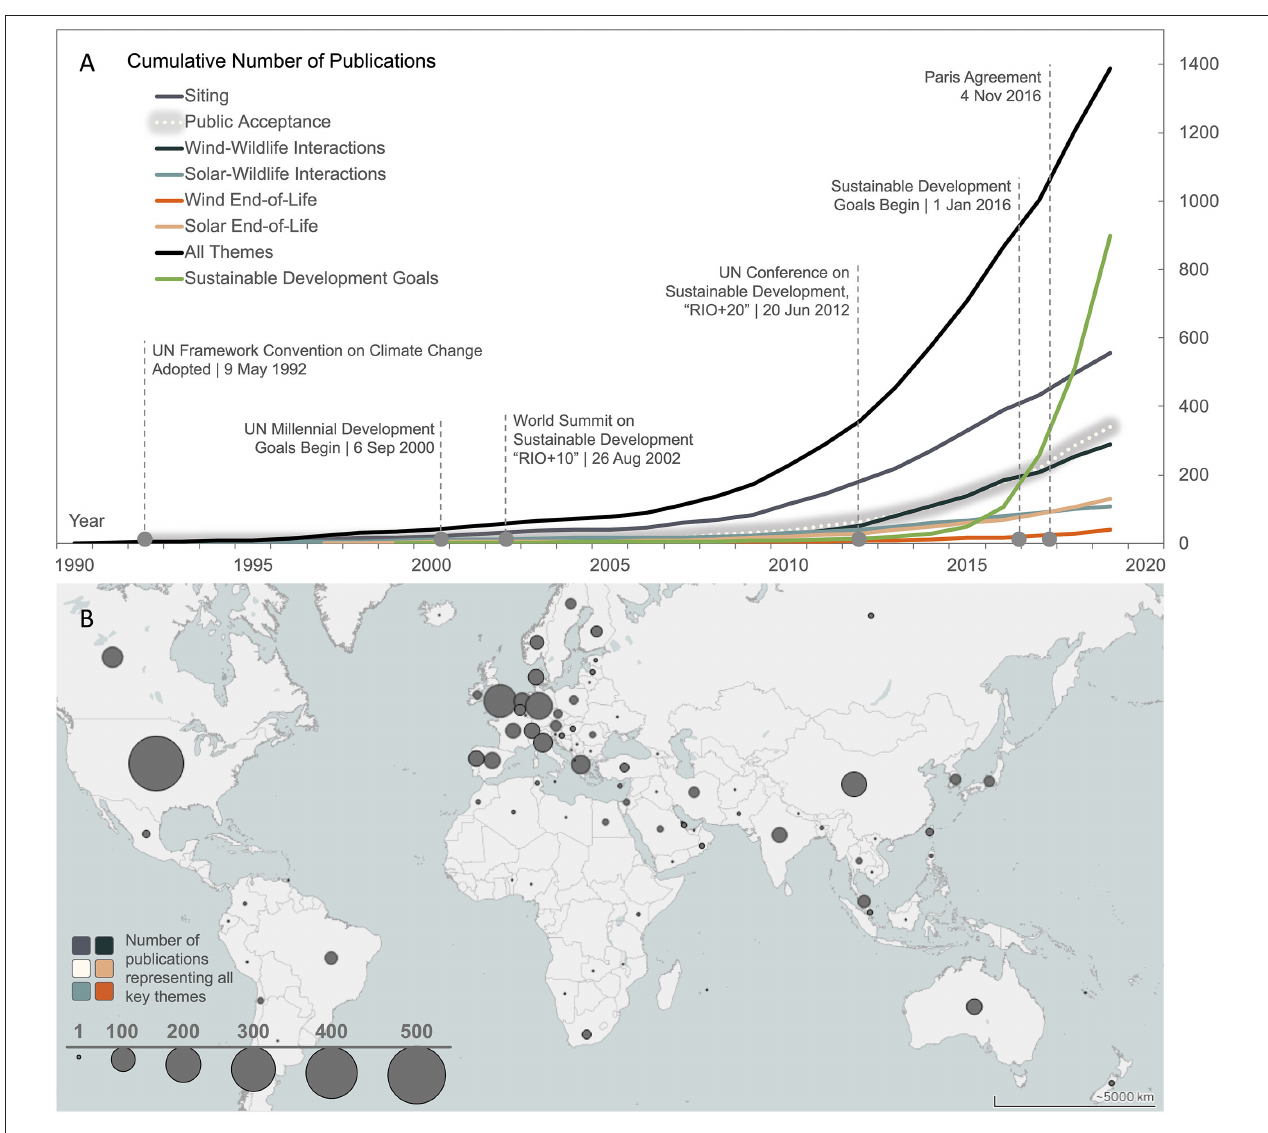
FIGURE 4 | Comparison of research productivity on energy-environment interactions across time and space. (A) The cumulative number of publications across siting, public acceptance, wind-wildlife interactions, solar-wildlife interactions, wind end-of-life, and solar end-of-life research themes, all key themes combined, and publications emphasizing United Nations Sustainable Development Goals from 1990 to 2019. (B) Global comparison of research productivity across all six themes by country from 1990 to 2019. Four siting publications published prior to 1990 are not shown. Data from: Web of Science (2020). Graphics use icons reproduced from the Noun Project